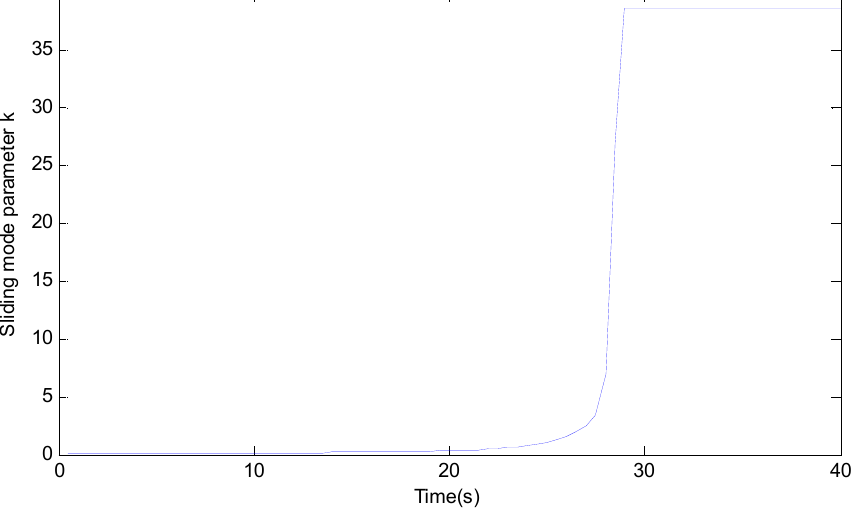
Figure 7. Curve of sliding mode parameter.